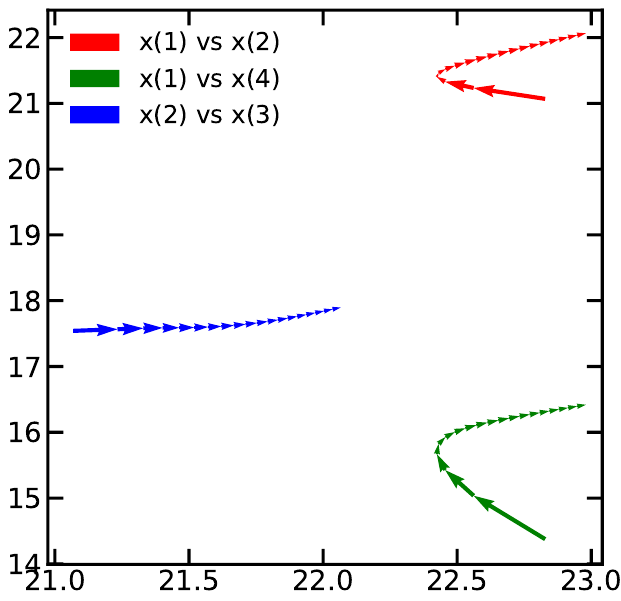
Figure 12. Phase diagram for normal prediction in sensors